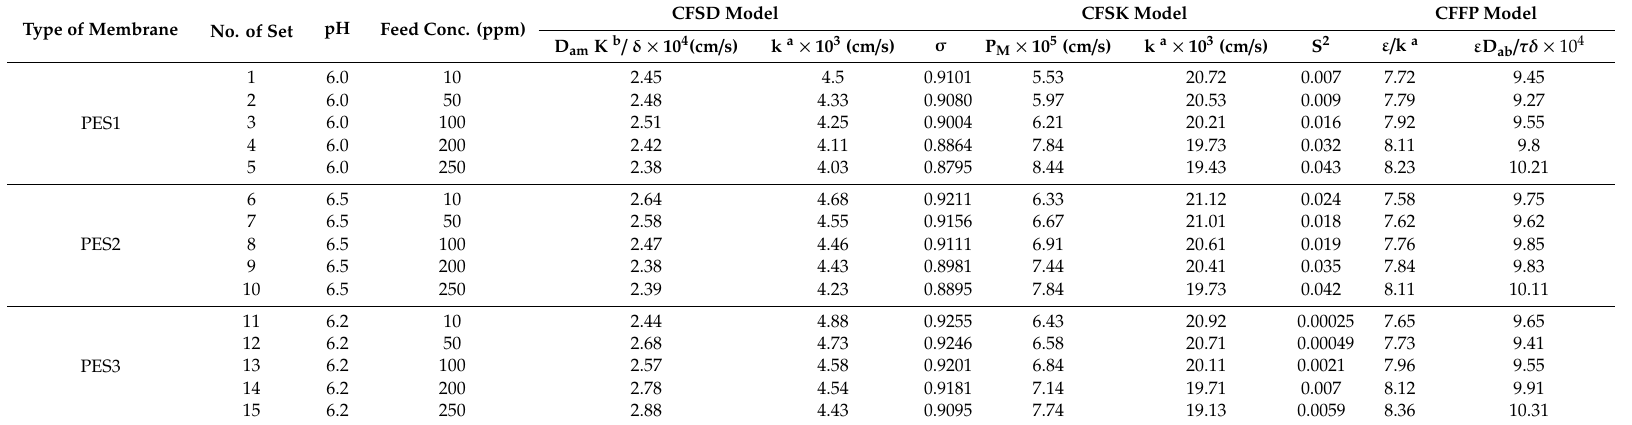
Table 3. Parameter estimated for various modules by a nonlinear estimated program (Pb 2 +